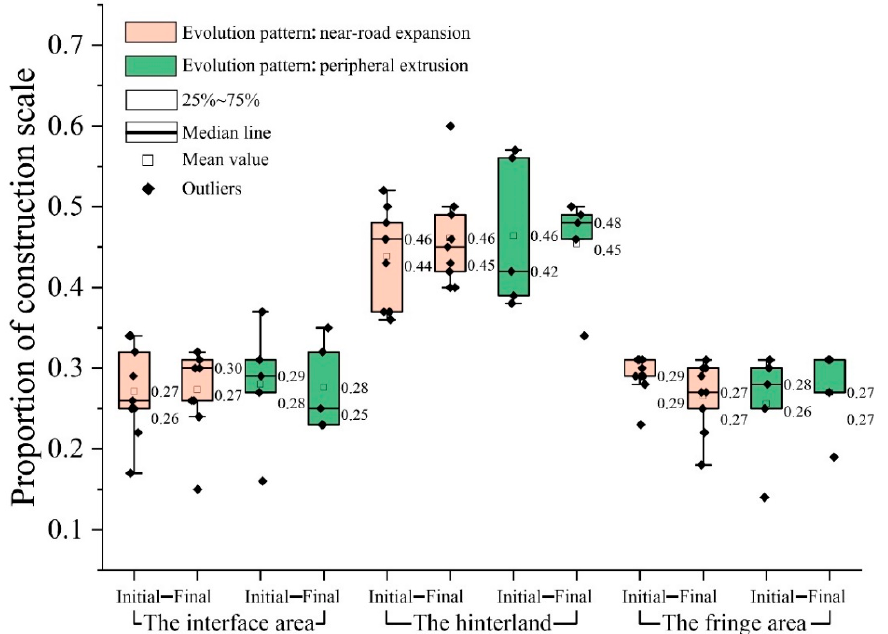
Figure 10. The proportion change of the construction scale in each spatial division under two expansion patterns.